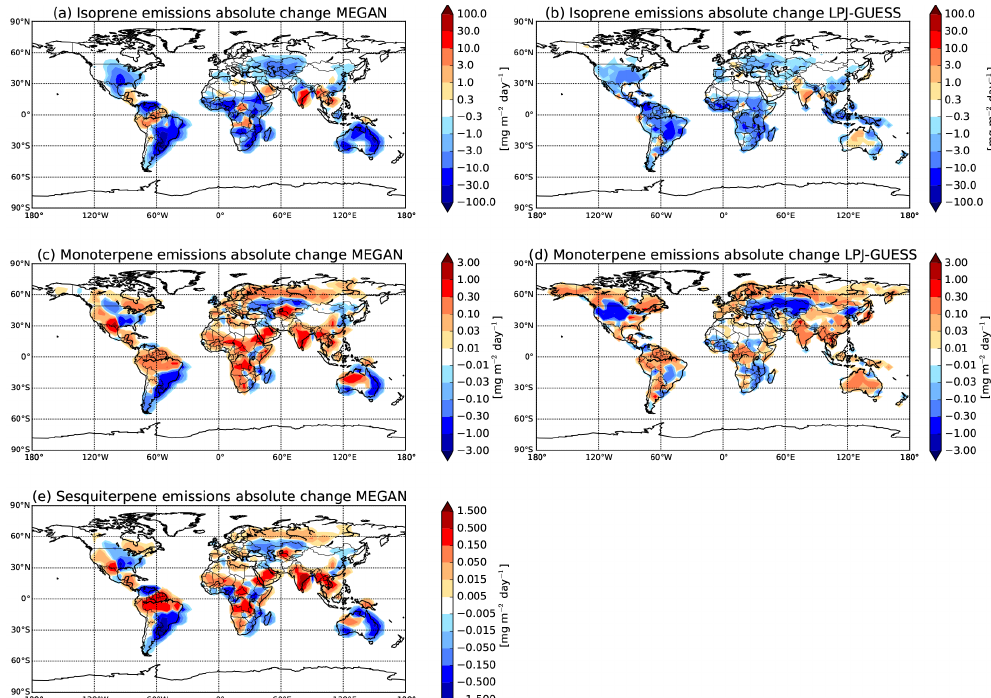
Figure 1. Absolute change in (a) isoprene, (c) monoterpene, and (e) sesquiterpene emissions between the years 1000–1010 and 1980–1990 in mgm − 2 day − 1 from the MEGAN terpenoid reconstruction, and absolute change in (b) isoprene, and (d) monoterpene emissions between the years 1000 and 2000 in mgm − 2 day − 1 from the LPJ-GUESS terpenoid reconstruction (Acosta Navarro et al., 2014). Note the change of scale between panels. An increase in emissions is represented in red, and a decrease in isoprene emissions in